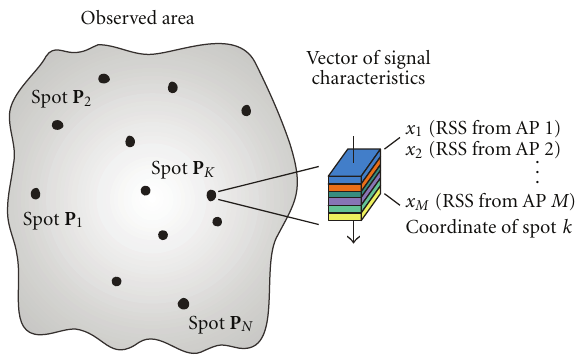
Figure 1: Radio map for fingerprinting algorithms using